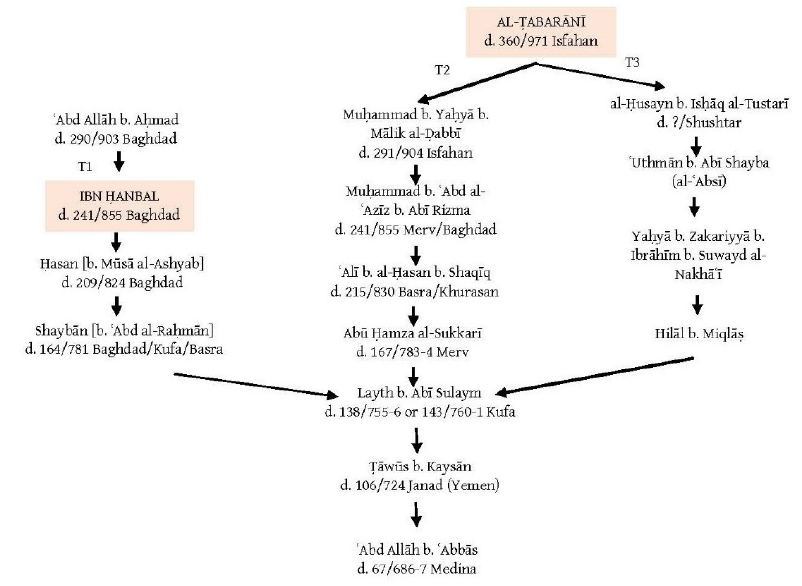
Figure 2. The isn ā d bundle of the Ibn ʿ Abb ā s-traditions from Layth. Figure 2. The isn¯ad bundle of the